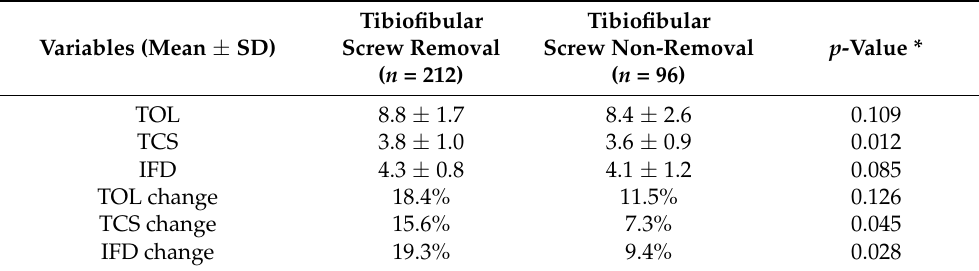
Table 4. Differences in radiographic changes between two follow-ups in the study groups.